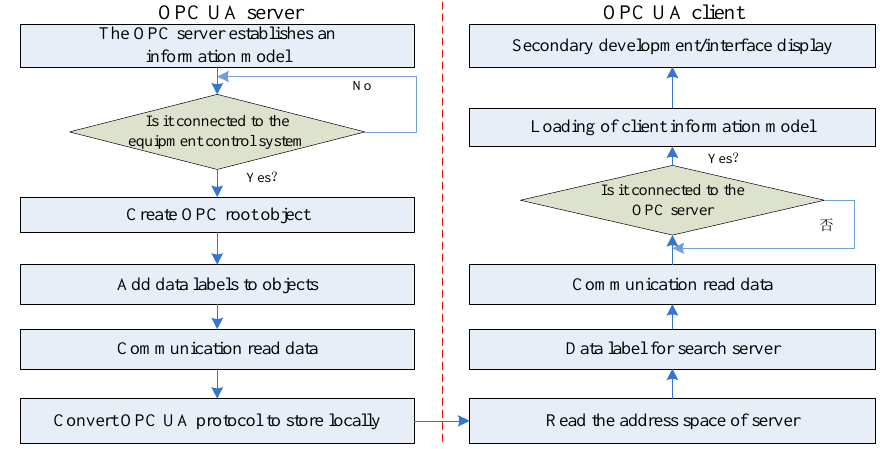
Figure 10. Information model validation process based on OPC UA.